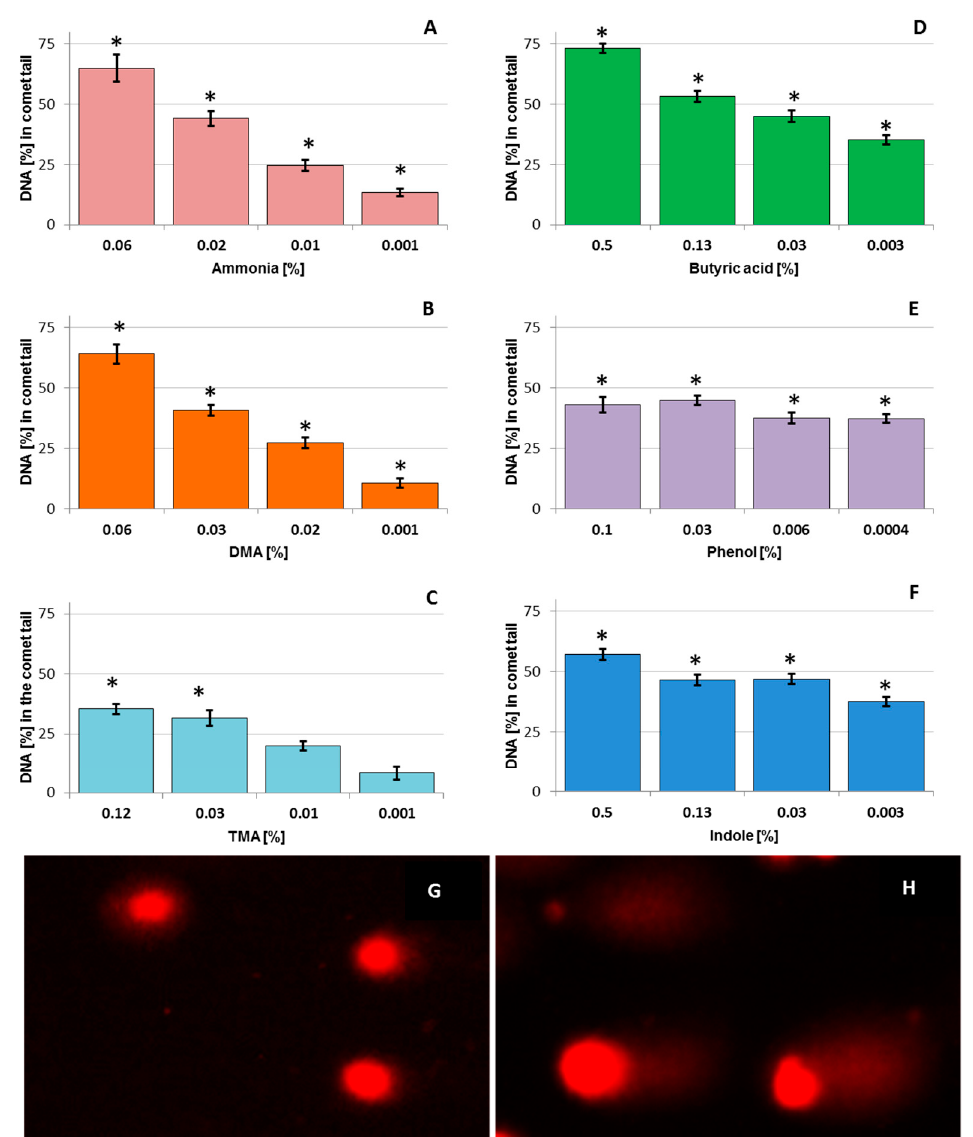
Figure 1. DNA damage in model chicken cell line (LMH) chicken cells after exposure to odorous compounds, such as ( A ) ammonia, ( B ) dimethylamine (DMA), ( C ) trimethylamine (TMA), ( D ) butyric acid, ( E ) indole and ( F ) phenol, expressed as the mean percentage of DNA in the comet tail in the alkaline comet assay. About 50 to 100 cells were analysed for each treatment. Data shown was obtained from two independent experiments. Error bars denote S.E.M. * Results were significantly different from unexposed control, ANOVA ( p < 0.05). G and H show representative images of 2.5 µ g/mL propidium iodide-stained comets: ( G ) untreated control and ( H ) sample exposed to 0.03% dimethylamine (extensive damage) in the alkaline comet assay.